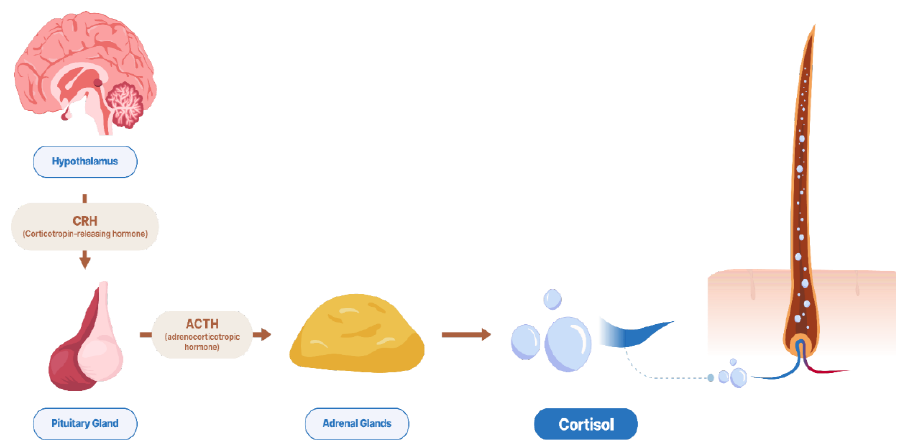
Figure 1. Infographic of cortisol incorporation to hair matrix from blood (Source: CO-ANI). Hair is a type of keratinous filament that grows out of the epidermis in mammals [72]. The structure of the hair matrix consists of different parts, but in general, it is formed by keratinized cells and has two main parts: the hair shaft and the hair follicle [72,73]. The hair follicle is a hair strand that originates in an epidermal penetration of the dermis. The part of the hair that is not anchored in the follicle but is largely exposed on the skin surface is called the hair shaft, and the hair root refers to the remainder of the hair that is anchored in the follicle and lies below the skin surface. The part of the hair root that ends deep in the dermis in the area of the hair bulb is called the hair matrix, which contains a layer of mitotically active basal cells. The hair papilla is the part of the connective tissue that contains blood capillaries and nerve endings from the dermis. The hair papilla is surrounded by the hair